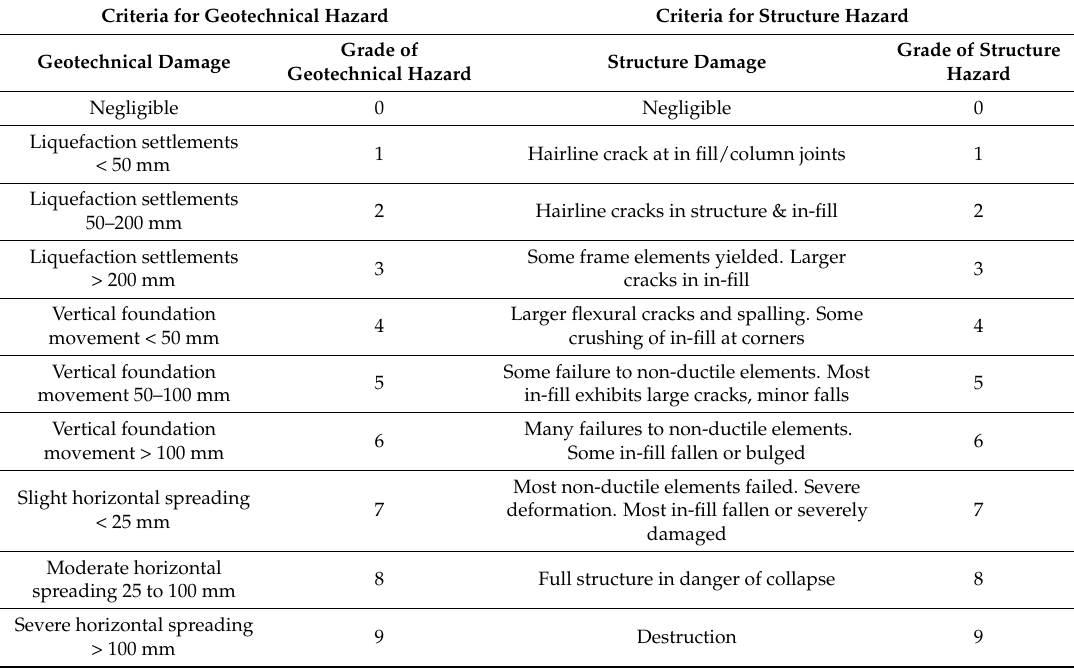
Table 3. Criteria for geotechnical hazard and structure hazard for the post-earthquake survey.